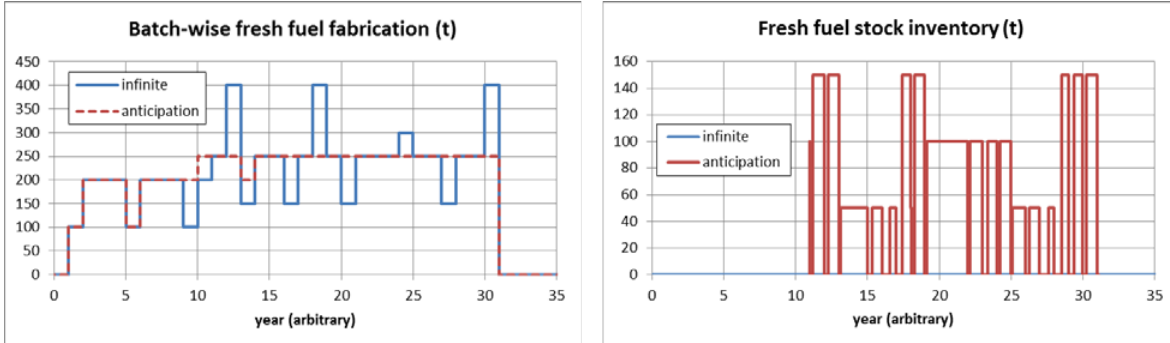
Figure 2. Impact of anticipation of fuel fabrication